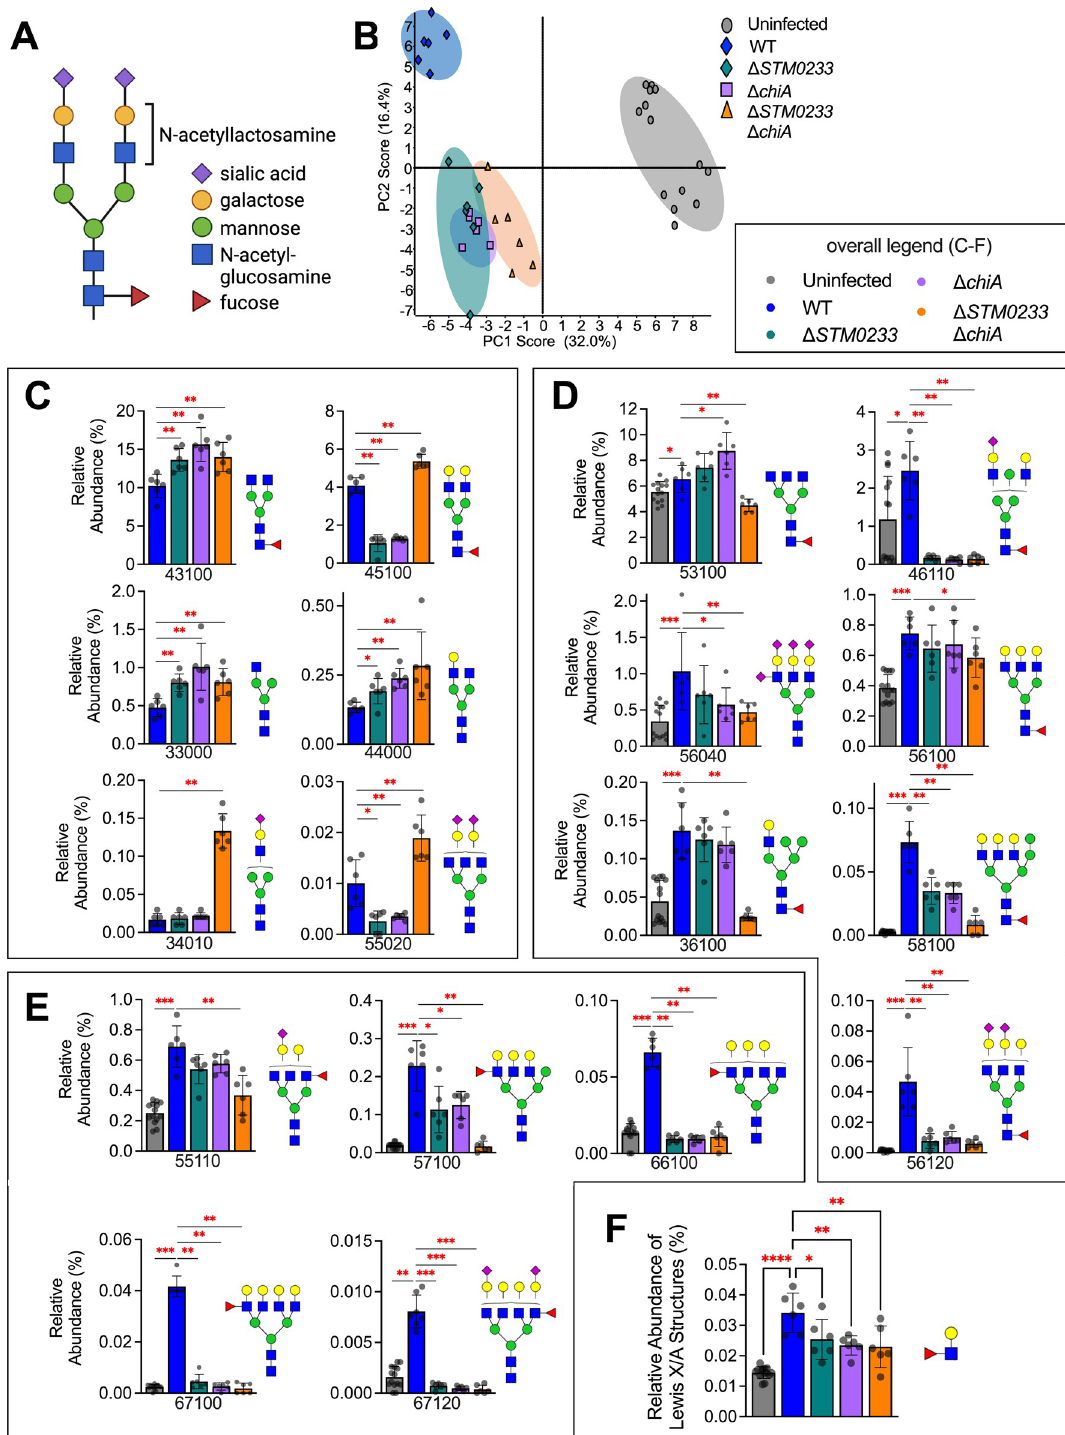
Fig 6. S . Typhimurium chitinases induce specific changes in the intestinal glycome during infection. (A) Common N -linked glycan structure. (B) Principal component analysis of the surface glycome composition of uninfected IPEC-1 cells and cells infected with WT S . Typhimurium or the chitinase-deficient strains. Uninfected n = 14, WT n = 6, Δ STM0233 n = 6, Δ chiA n = 6, Δ STM0233 Δ chiA n = 6. (C) Relative abundance of glycan species that increase during infection with Δ STM0233 Δ chiA compared to WT S . Typhimurium. (D) Relative abundance of selected glycans species that increase during WT infection compared to uninfected but do